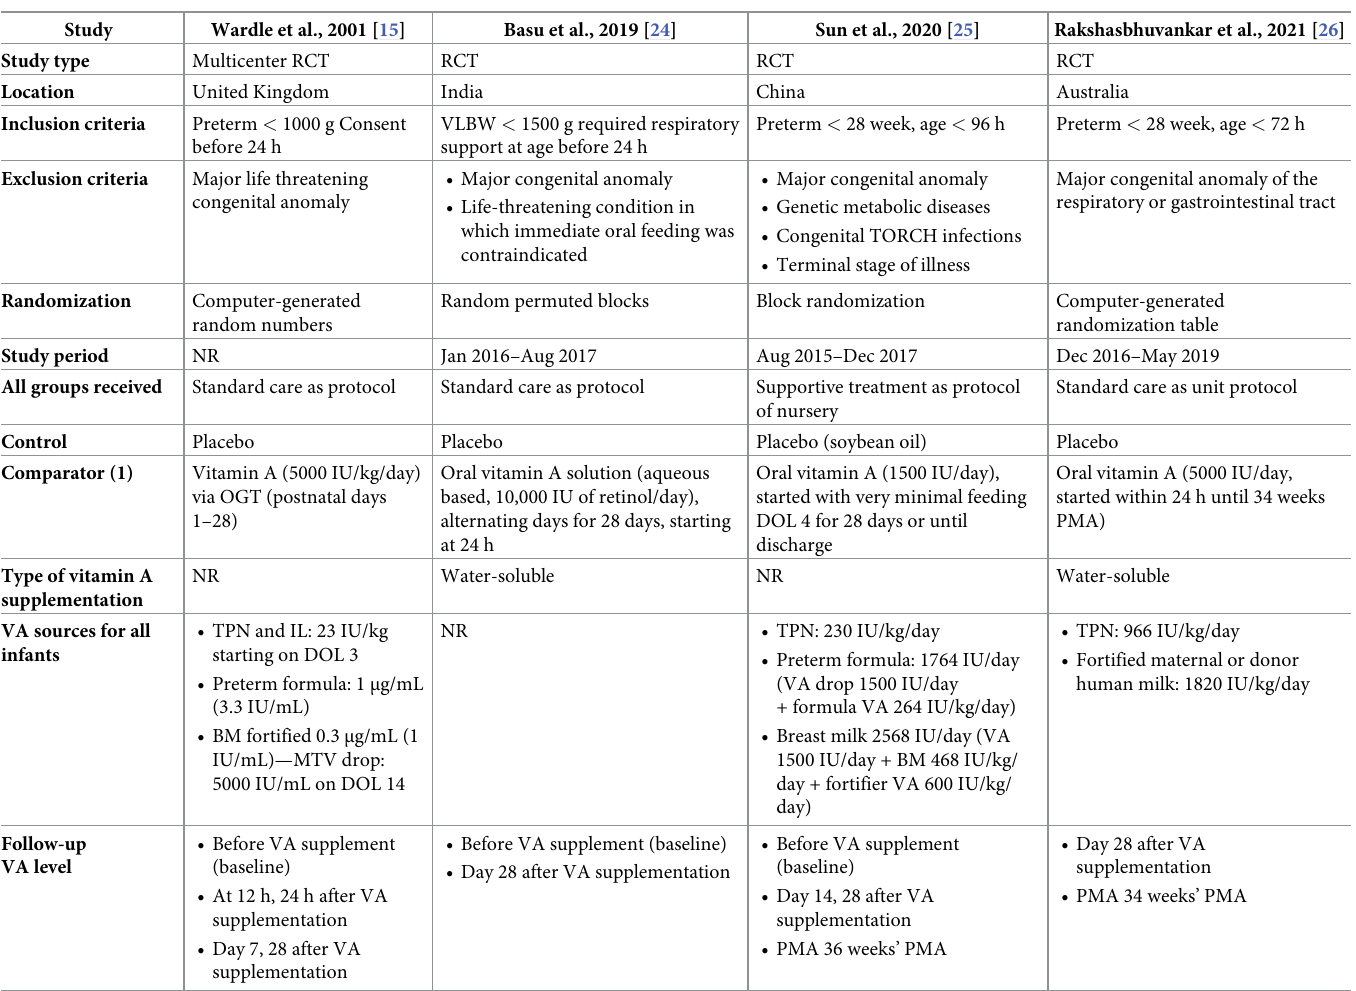
Table 1. Characteristics of the included